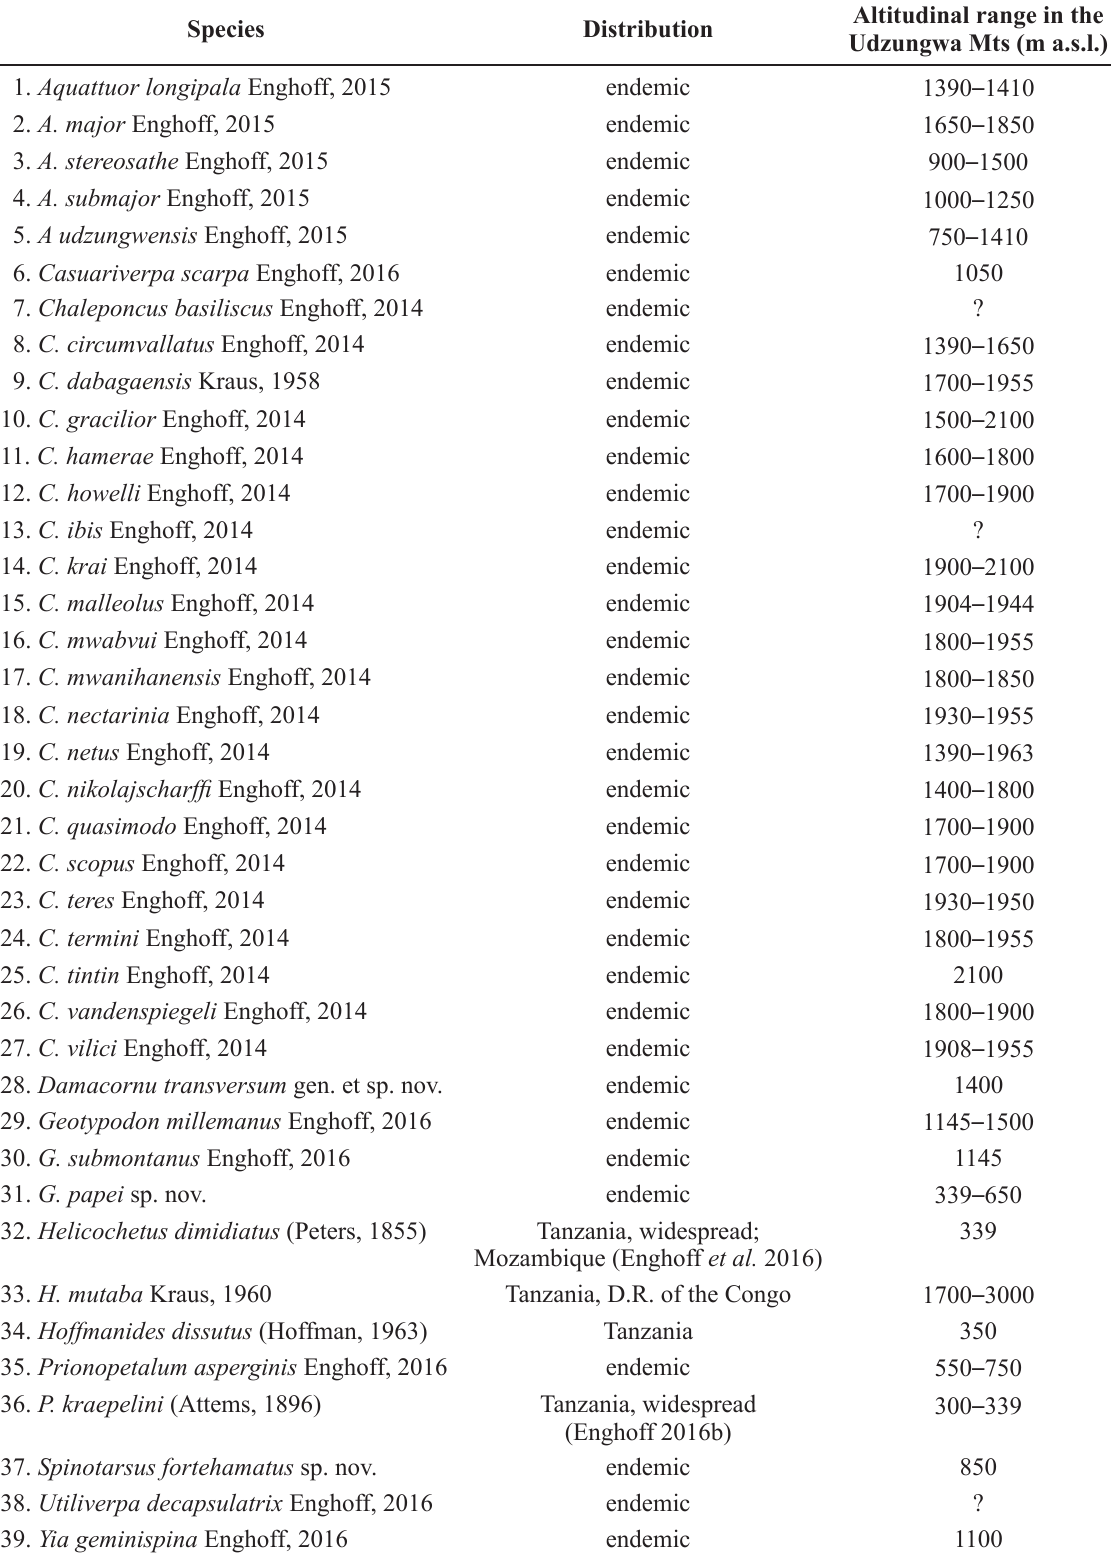
Table 3. Species of Odontopygidae known from the Udzungwa Mts. Endemic = endemic to the Udzungwa